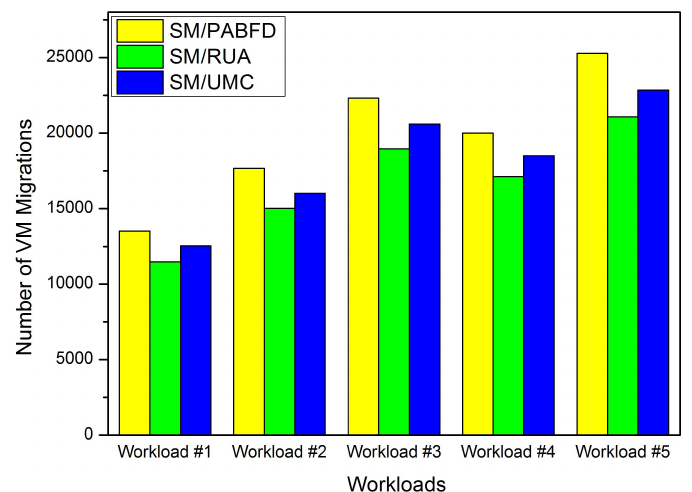
Figure 5. The number of VM migrations.